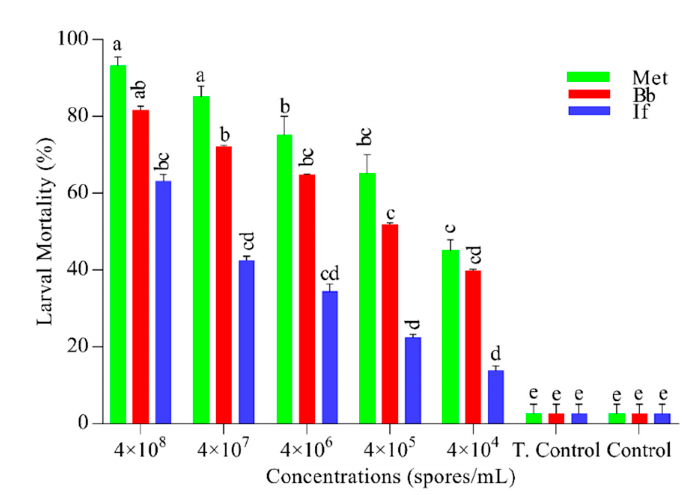
Figure 1. Larvicidal activity of entomopathogenic fungi. Mortality was recorded until seven days after every 24 h. Green, red, and blue bars represent the larval mortality of Plutella xylostella , after exposure to different concentrations of Metarhizium anisopliae (Met), Beauveria bassiana (Bb) , and Isaria fumosorosea (If) respectively. While T. Control is tween control (0.05% aqueous diluted) and in Control, distilled water was used. Error bars show 95% confidence intervals (CI). Letters indicate significant differences at p < 0.05.